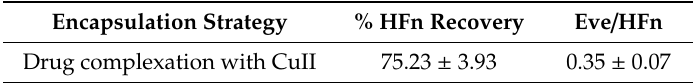
Table 1. Summary of yields of HFn recovery after Everolimus encapsulation. Encapsulation Strategy Data were generated from 26 samples of HEve.